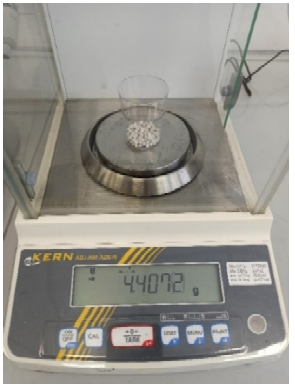
Figure 2. Kern ABJ 220-4NM analytical scales.